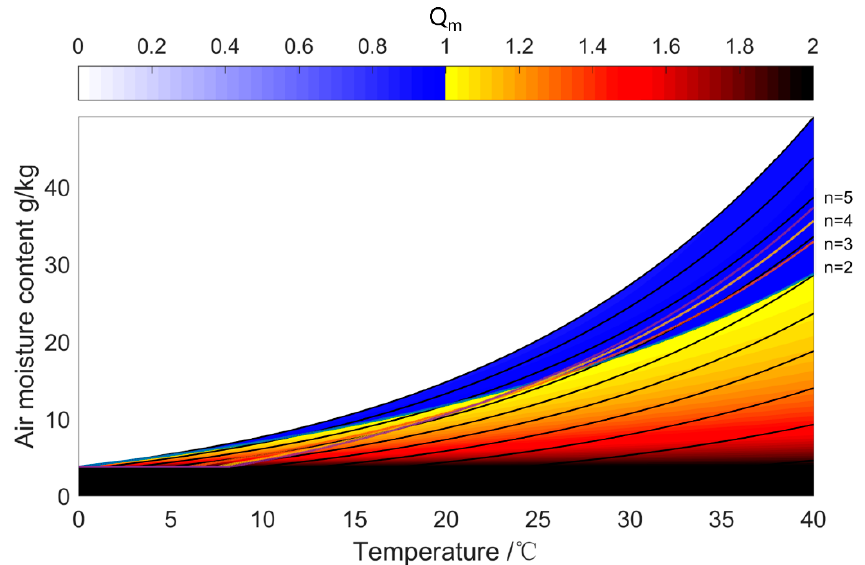
Figure 4. Q m , the ratio of energy consumption by single-stage to energy consumption by